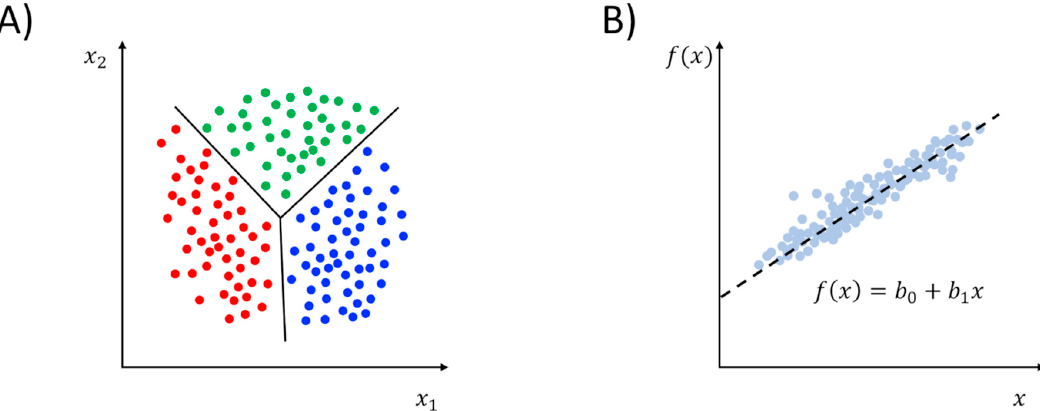
Figure 6. Pictorial representation of supervised learning class of methods: classification (panel ( A ), linear discriminant analysis (LDA) is displayed as an example) and regression (panel ( B ), linear regression displayed as an example,).